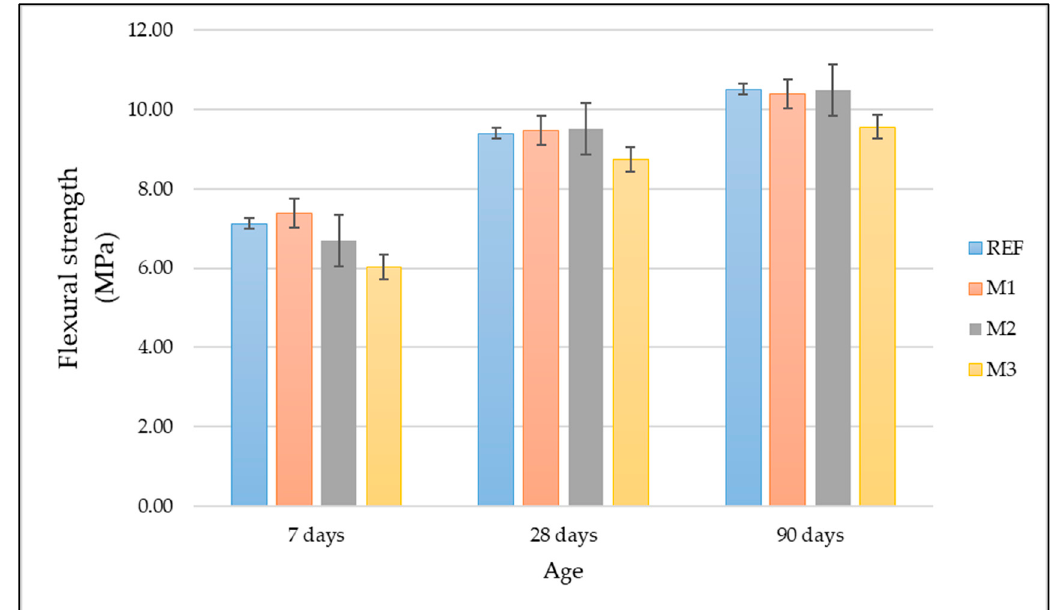
Figure 4. Results of the mechanical flexural strength test performed on the mortar specimens analyzed at 7, 28 and 90 days.